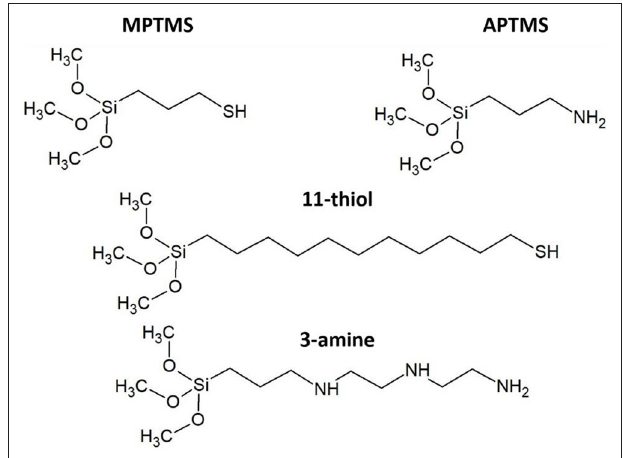
FIGURE 3 | The four different applied silane molecules are based on two thiols (MPTMS and 11-thiol) and two amines (APTMS and 3-amine).